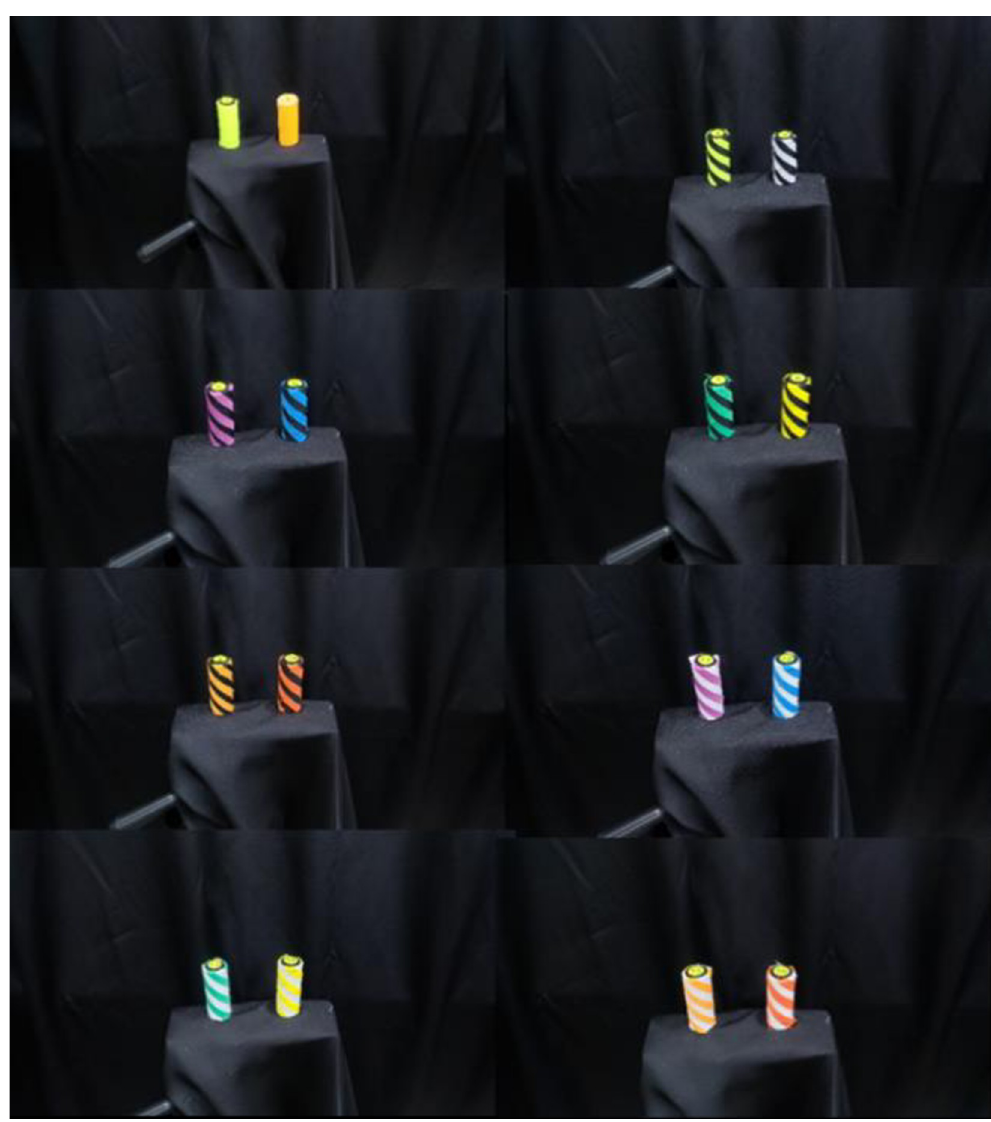
Fig 1. Visibility evaluation samples with a total of 16 different color